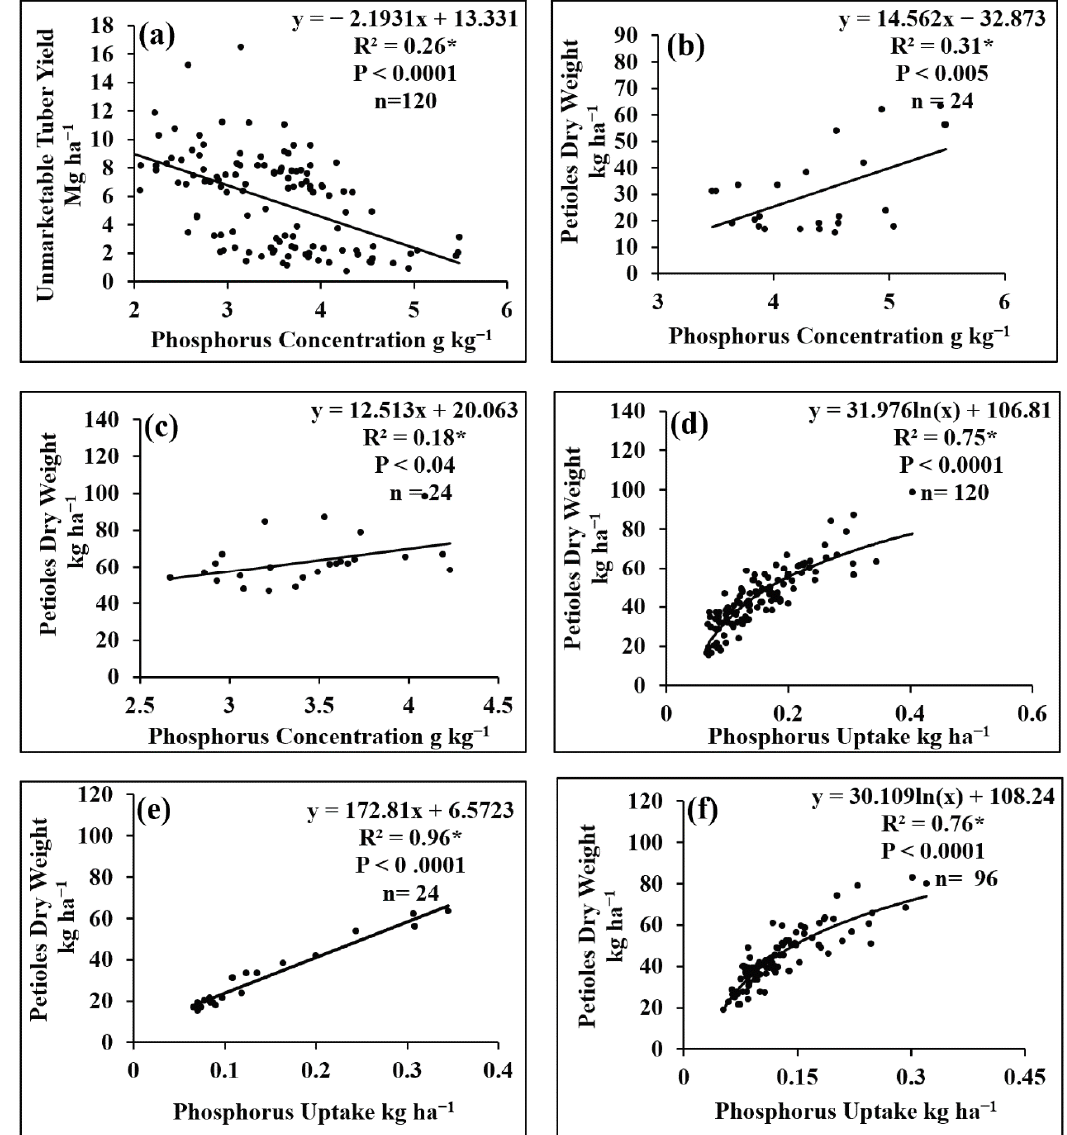
Figure 6. Relationships between phosphorus concentration and unmarketable tuber yield at combined sites ≥ 6 soil pH ( a ), petiole dry weight for ‘Shepody’ ( ≥ 6 soil pH) ( b ), and petiole dry weight for ‘Superior’ variety ( ≥ 6 soil pH) ( c ), and the relationships between phosphorus uptake and petiole dry weight at combined sites with ≥ 6 soil pH ( d ), and the ‘Shepody’ variety at soil pH ≥ 6 ( e ), and all combined sites < 6 soil pH ( f ). * Significantly different at P < 0.05 .